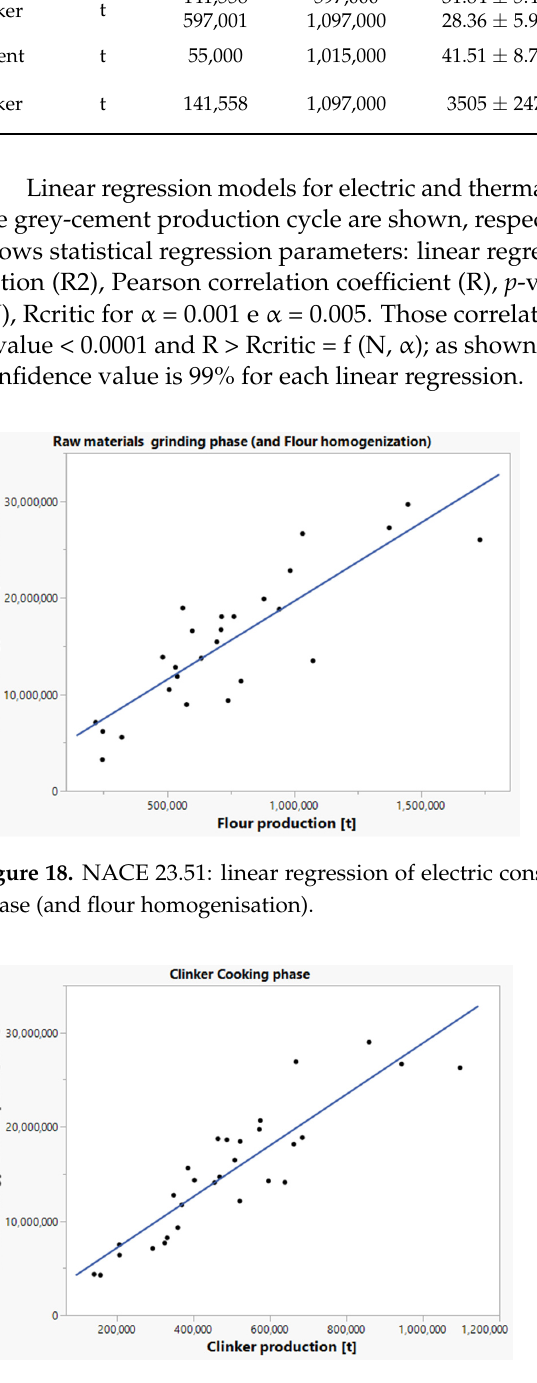
Figure 19. NACE 23.51: linear regression of electric consumption of the clinker cooking phase.